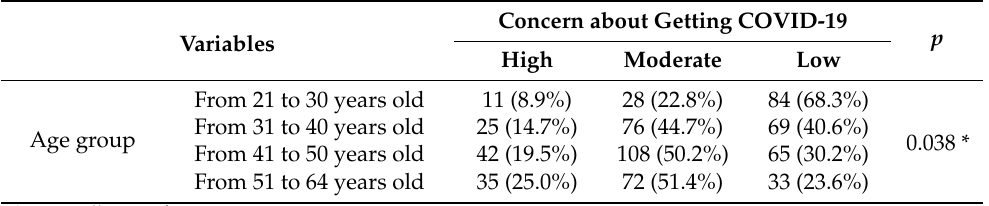
Table 4. AssociationbetweenconcernaboutthespreadofCOVID-19andtheagegroupoftheparticipants.